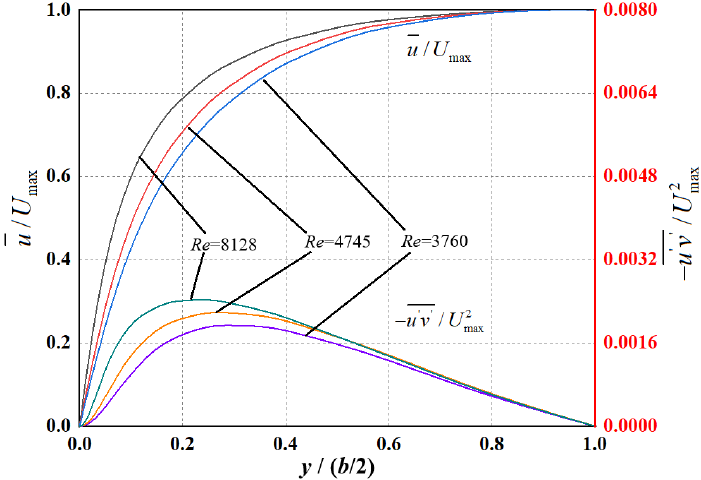
Figure 16. Velocity and Reynolds shear stress component distribution on Y direction centerline.